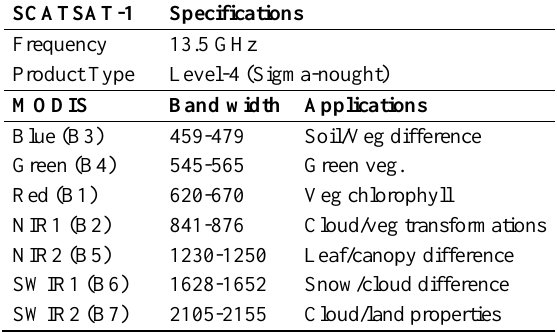
Table 1 . Technical details of input